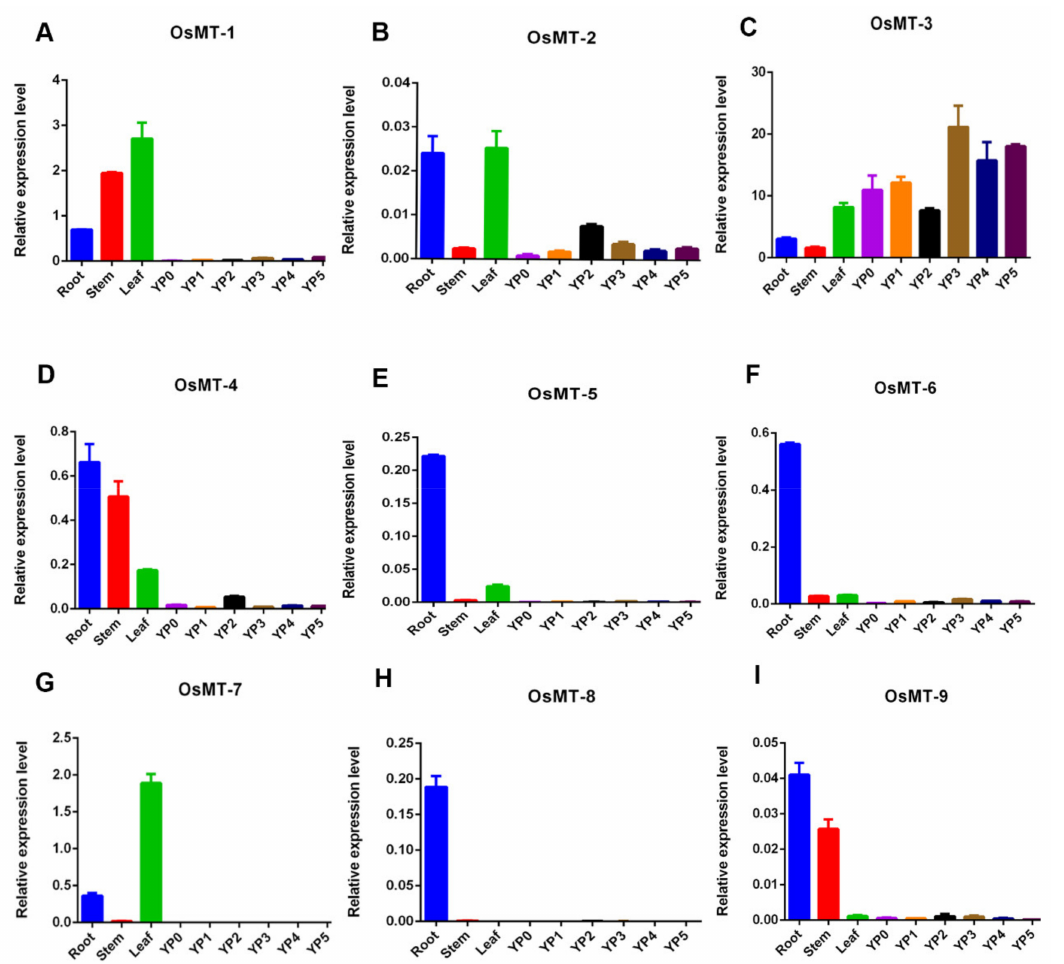
Figure 5. Expression profiles of OsMT genes in different tissues. Real-time quantitative PCR, YP0: 0–0.5 cm panicle, YP1: 0.5–1 cm panicle, YP3: 1–2 cm panicle, YP4: 2–3 cm panicle, YP5: 3–4 cm panicle. The error bars show the standard